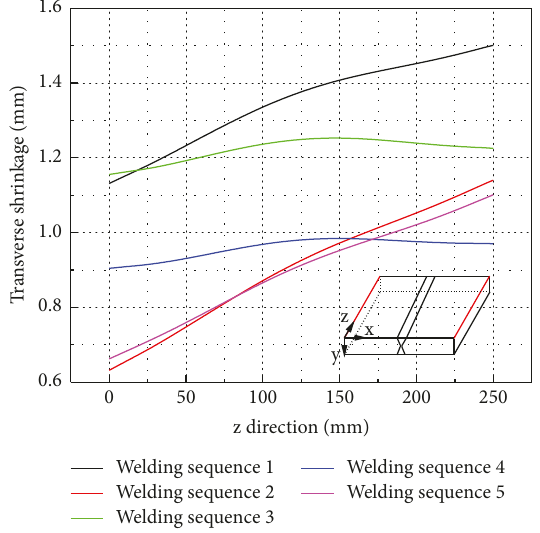
Figure 19: Comparison of the transverse